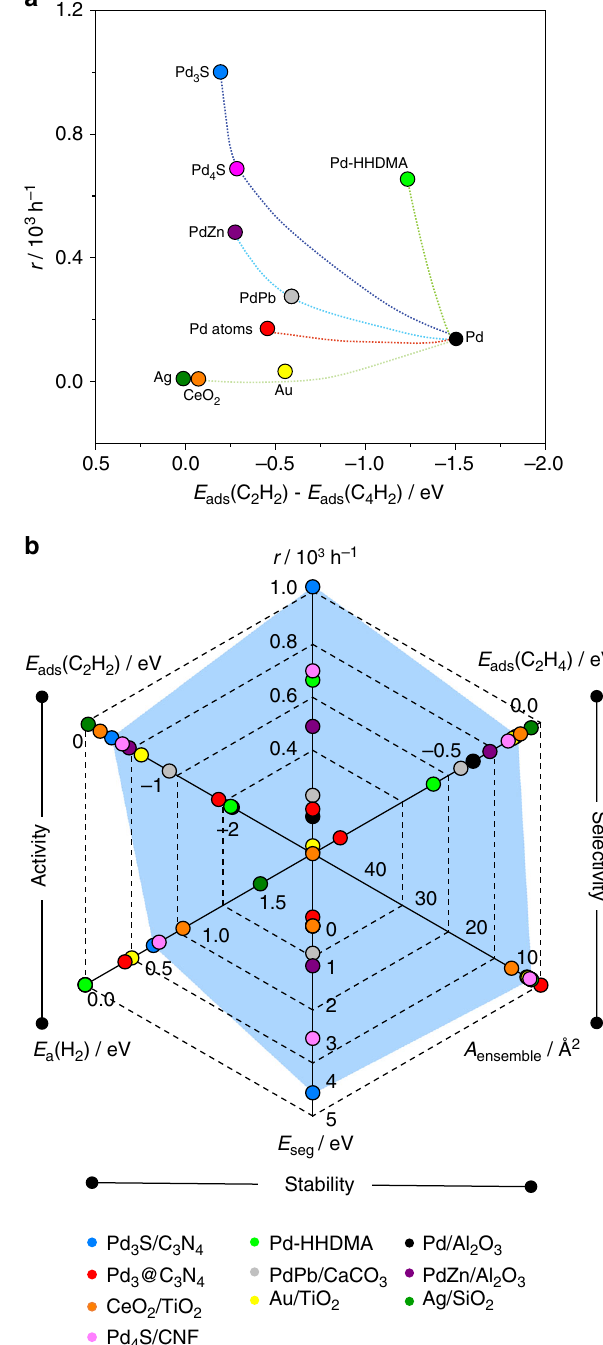
Fig. 7 Catalytic descriptors for alkyne semi-hydrogenation. a Rate of alkene formation at T = 303 K and P = 1 bar versus the differential adsorption energy of acetylene and ethene for all classes of catalysts. b Radar plot charting the relation of the rate with key theoretical indicators for the activity: the adsorption energy of the alkyne ( E ads (C 2 H 2 )) and the activation energy for H 2 dissociation ( E a (H 2 )), selectivity: the alkene adsorption energy ( E ads (C 2 H 4 )), and the ensemble area ( A ensemble ), and the stability: the segregation energy ( E seg ). Values closest to the perimeter lead to enhanced properties. The blue shaded area connects the optimal values to date found for the Pd 3 S